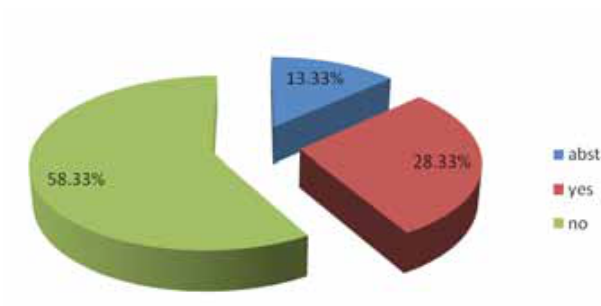
Graph 3: Percentage of Respondent Batik SMEs Having Their Trademarks Registered at DGIPR Indonesia